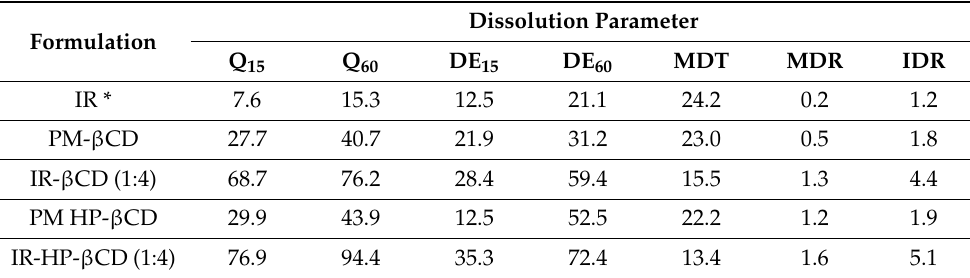
Figure 2. The in vitro release profile of irbesartan from irbesartan solution, PMs, and the corresponding cyclodextrin inclusion complexes in phosphate buffer (Mean ± SD, n = 4). Table 2. Dissolution parameters of irbesartan from irbesartan solution, PMs, IR- β CD, and IR-HP- β CD inclusion complexes (mean ± SD, n =